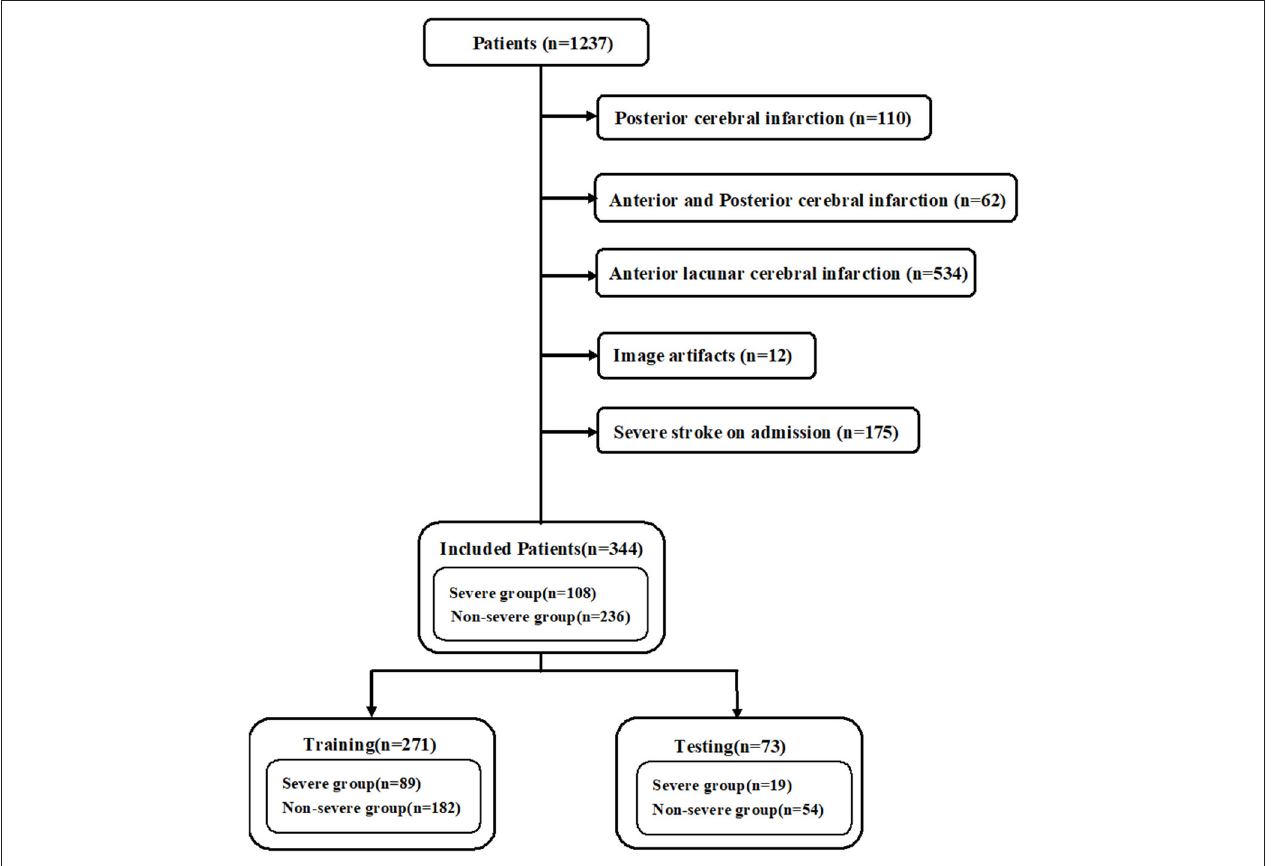
FIGURE 1 | Flow chart illustrating patients